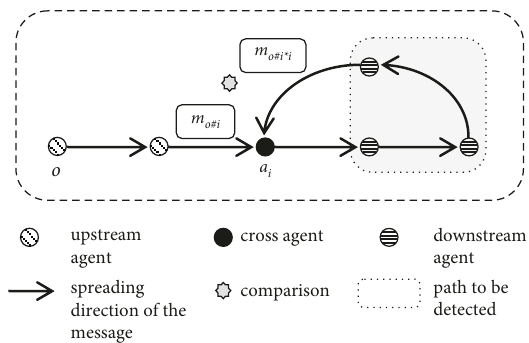
Figure 2: Example for feedback path reputation detection.